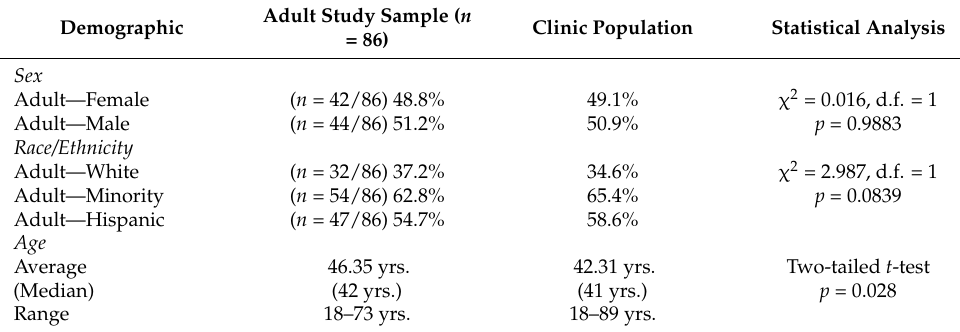
Table 2. Demographic analysis of adult study